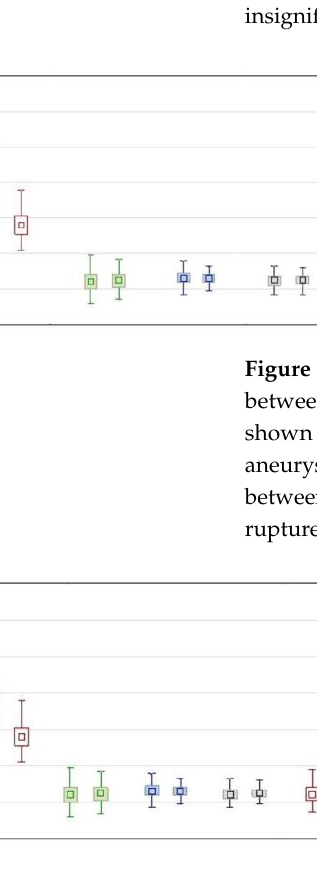
Figure 4. On the left, a comparison of diameters of the aorta between ruptured and unruptured aneurysms with the neck segment present. Diameters in cm. Boxplots are shown in pairs. The left one is diameter for ruptured, the right one is diameter for unruptured aneurysms. Only D MAX difference is significant with p < 0.05. On the right, a comparison of ratios between ruptured and unruptured aneurysms. Boxplots are shown in pairs. The left one is ratio for ruptured, the right one is ratio for unruptured aneurysms. All differences significant at p < 0.05.